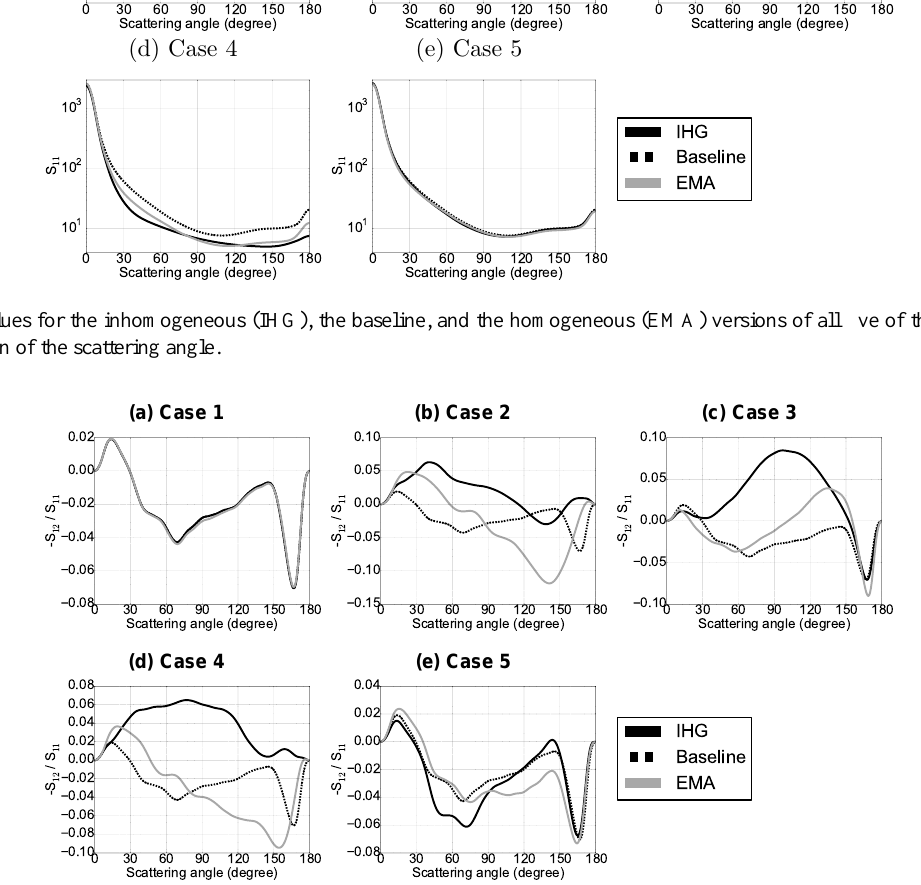
Figure 5. − S 12 /S 11 values for the inhomogeneous (IHG), the baseline, and the homogeneous (EMA) versions of all five of the internal structure cases as a function of the scattering